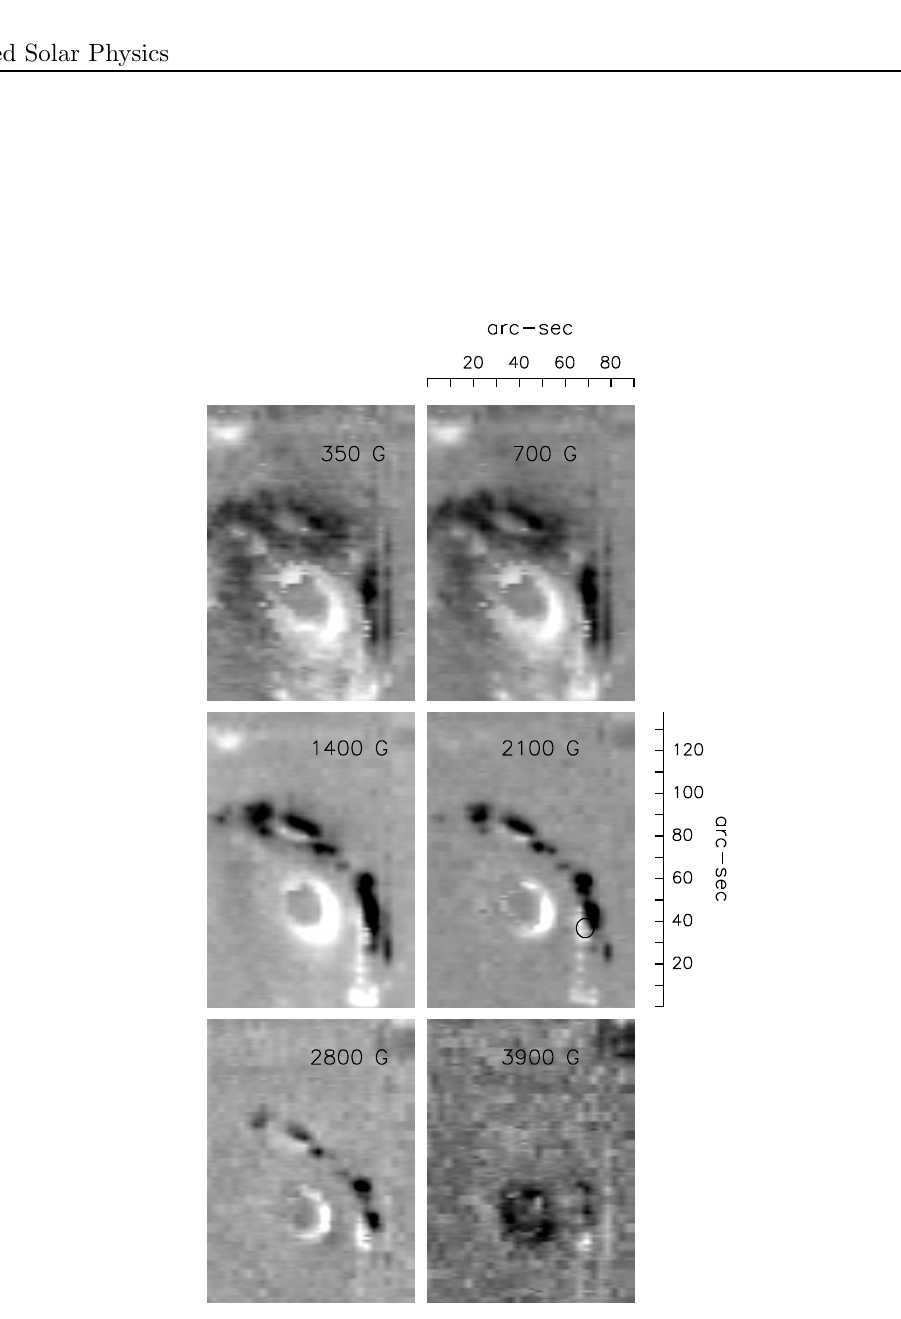
Figure 16: Maps of the magnetic field strength in a magnetically complex active region. The Zeeman shifted sigma components of the line are sliced at different wavelength positions corresponding to the magnetic field values listed in each sub-image. Magnetic fields of various strengths are seen to occur in the same spatial pixels, while the stronger magnetic fields are limited to the umbral regions. Image reproduced with permission from Jennings et al. (2002), copyright by